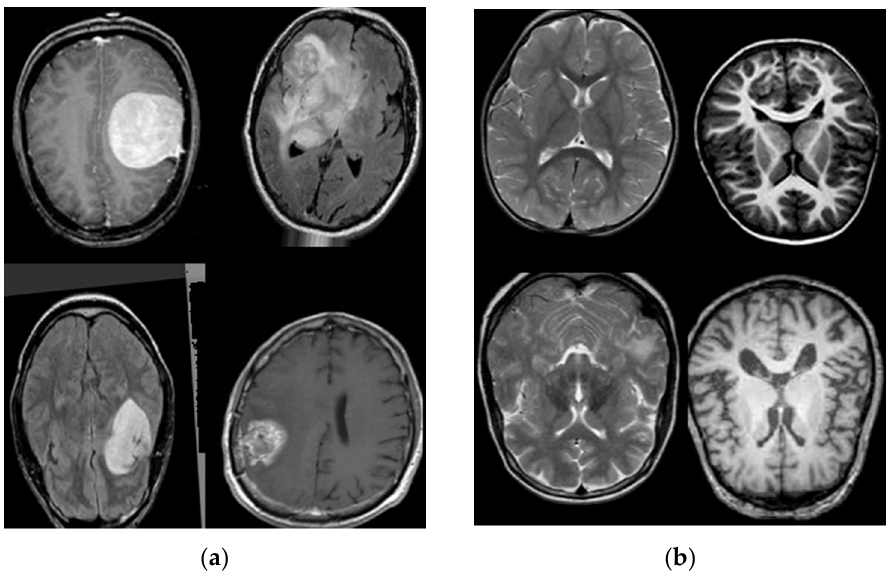
Figure 2. ( a ) Samples of abnormal T1, T2 and FLAIR MR brain images and ( b ) the samples of normal T1, T2 and FLAIR MR brain images.